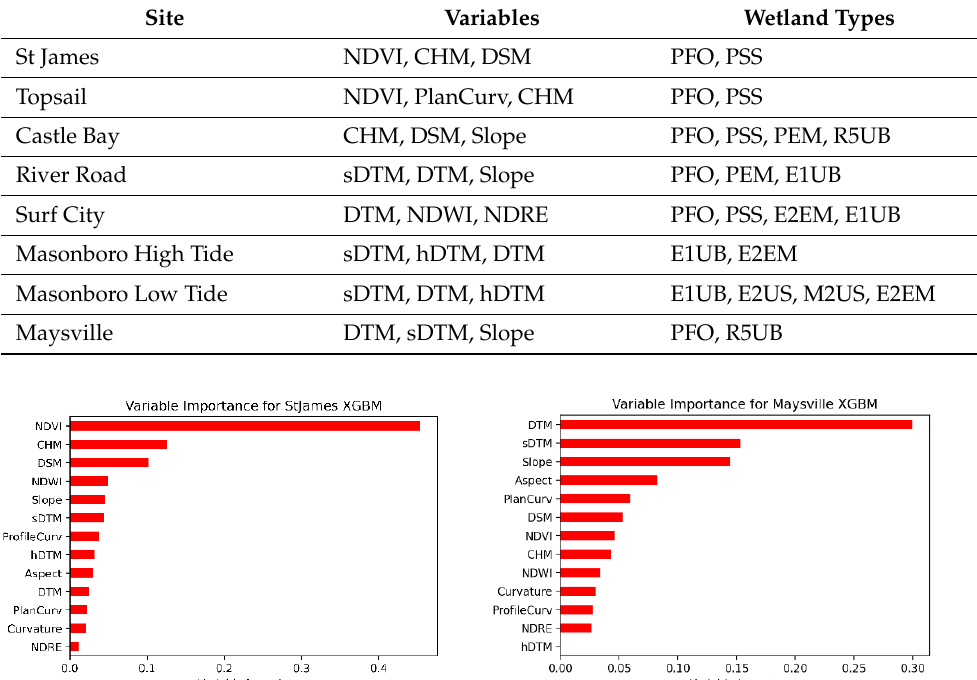
Table 3. List of sites and most important variables when creating XGBM decision trees, ranked from highest to lowest.